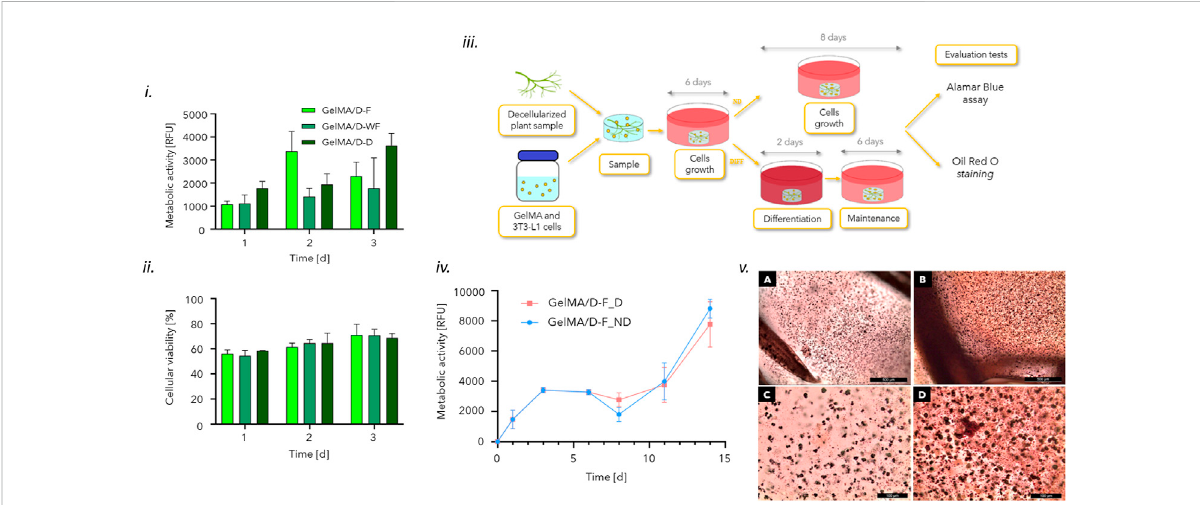
FIGURE 3 i) Metabolic activity (RFU) values at the considered timepoints for 3T3-L1 cells encapsulated in crosslinked GelMA/D-F, GelMA/D-WF, and GelMA/D-D. ii) Cellviability[%]obtainedbyLive/Deadstainingupto7 daysofculture. iii) Schemeof3T3-L1cellseeding,growthanddifferentiationin the crosslinked GelMA/D-F structures. Cells were embedded in the hydrogel before crosslinking, and crosslinked samples were incubated in preadipocytesculturemediumfor7 days;then,halfofthesampleswerekeptgrowinginpreadipocytesgrowthmedium,whilehalfwasinduced to differentiation for 48 h in differentiation medium, replaced with a maintaining medium. iv) Metabolic activity (RFU) for 3T3-L1 cells embedded in crosslinkedGelMA/D-F1,4,6,8,11,and14 daysafterseeding;after6 daysofculture,cellswerekeptingrowthmedium(GelMA/D-F_ND)orinduced